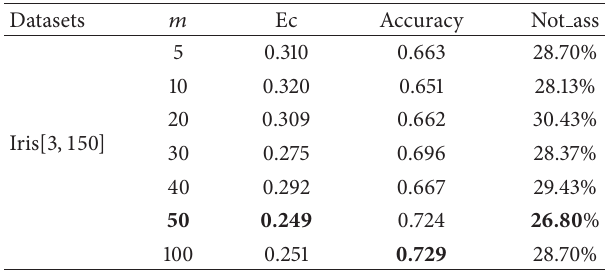
Table 3: Error classification and accuracy coefficients found on Iris dataset. Average on 20 trials, 100 iterations per